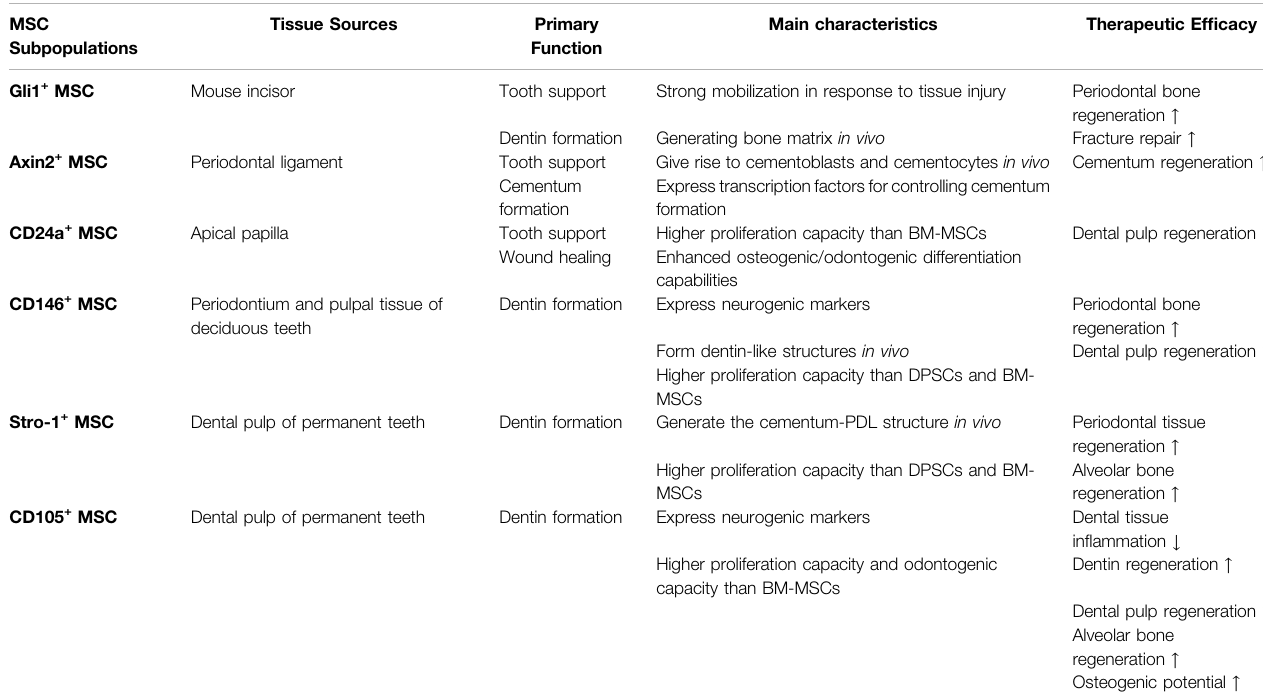
TABLE 1 | Summary of main characteristics and therapeutic ef fi cacy of MSC